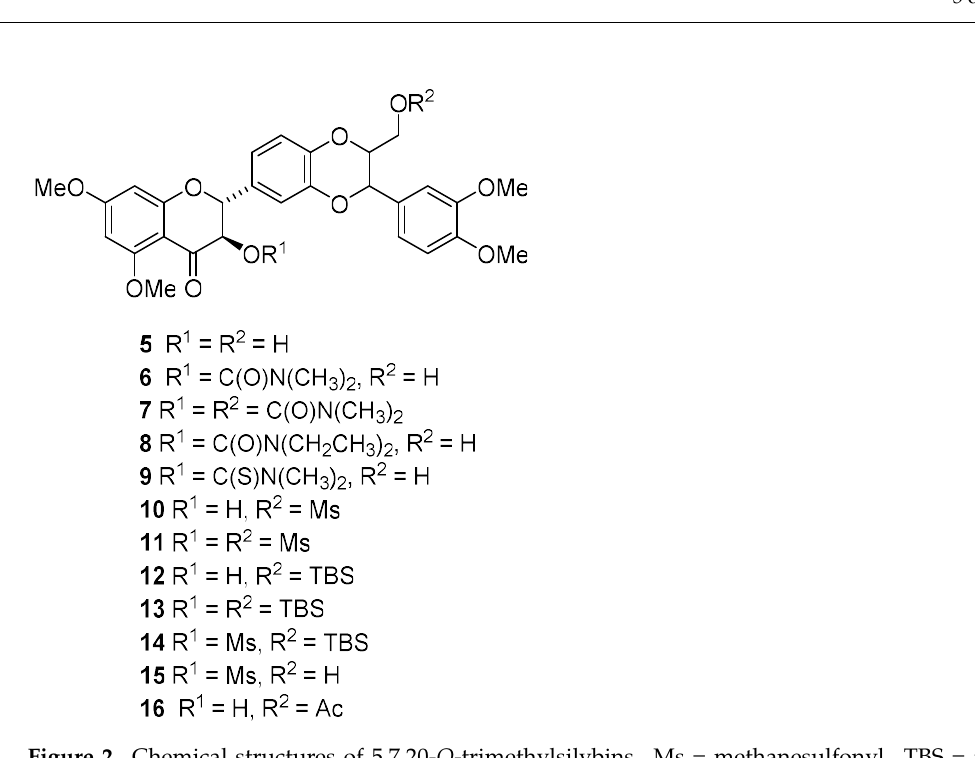
Figure 2. Chemical structures of 5,7,20- O -trimethylsilybins. Ms = methanesulfonyl. TBS = tert -butyl(dimethyl)silyl. Ac = acetyl. Table 1. Antiproliferative activity of 5,7,20- O -trimethylsilybins 5 – 16 .